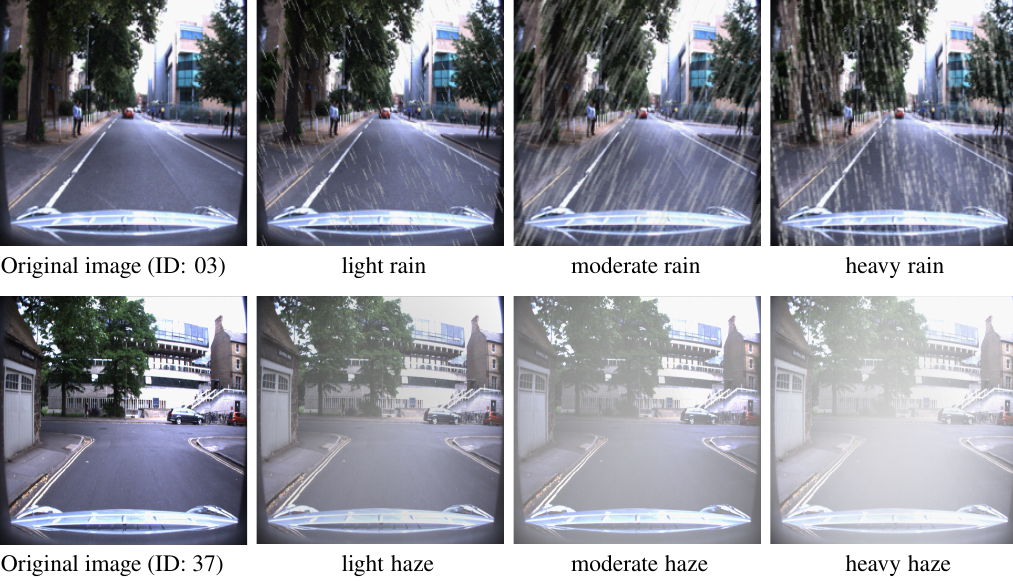
Figure 8. Intersection image with data augmentation by a nonlinear raining model ( first row ) and haze model ( second row ). Images samples are from